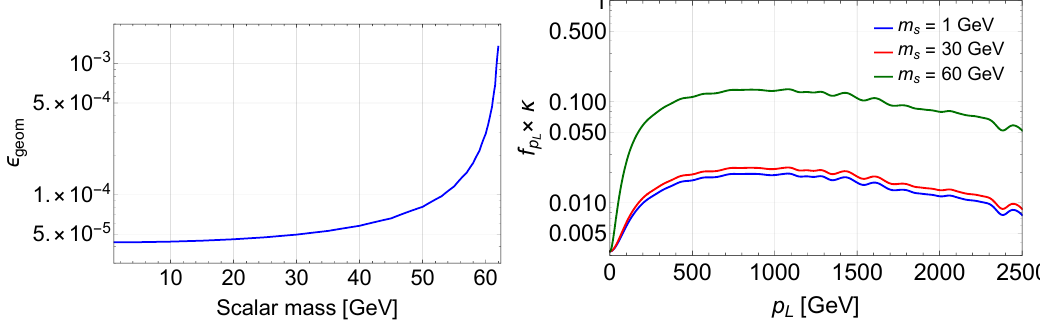
Figure 5 . Left panel : Geometric acceptance of scalars at FASER 2 obtained using p L distribution of Higgs bosons, see eq. (2.8). Right panel : the distribution function of Higgs bosons by the longitudinal momentum p L multiplied by the enhancement factor (cid:20) (2.10) for the masses of the scalar m S = 0, 50 and 60